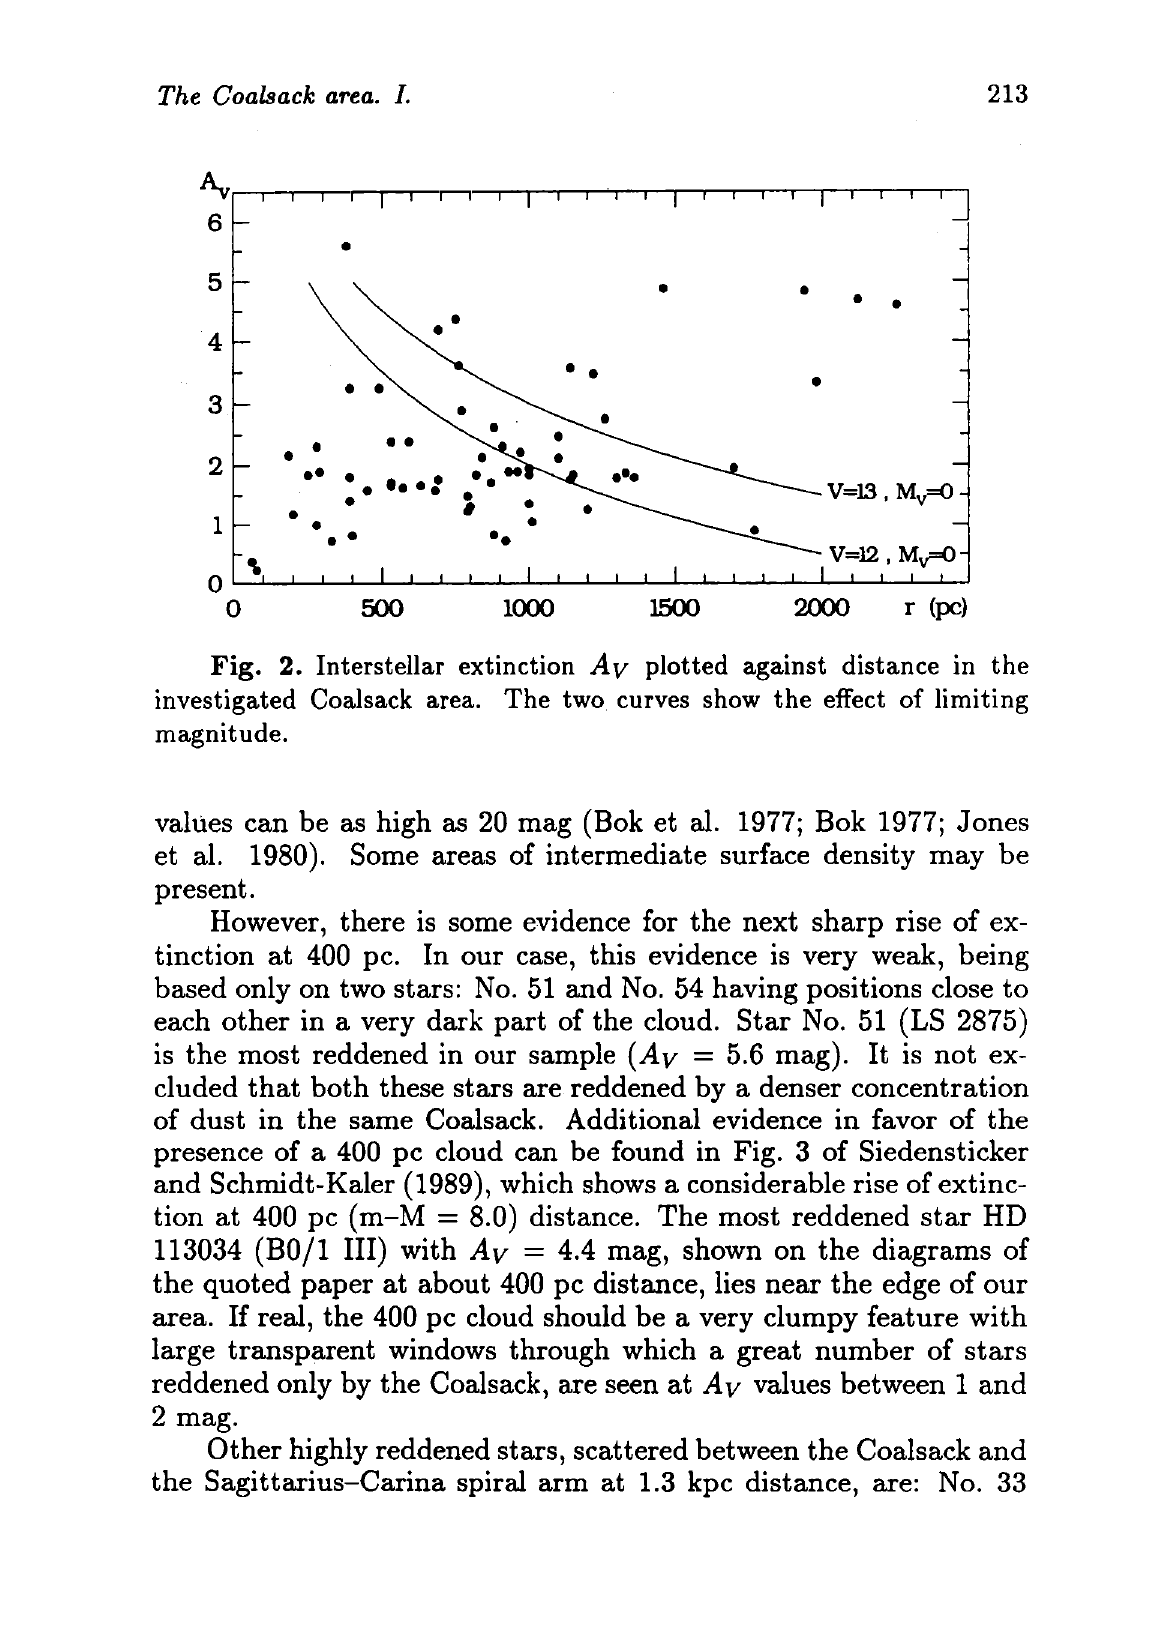
Fig. 2. Interstellar extinction Ay plotted against distance in the investigated Coalsack area. The two curves show the effect of limiting